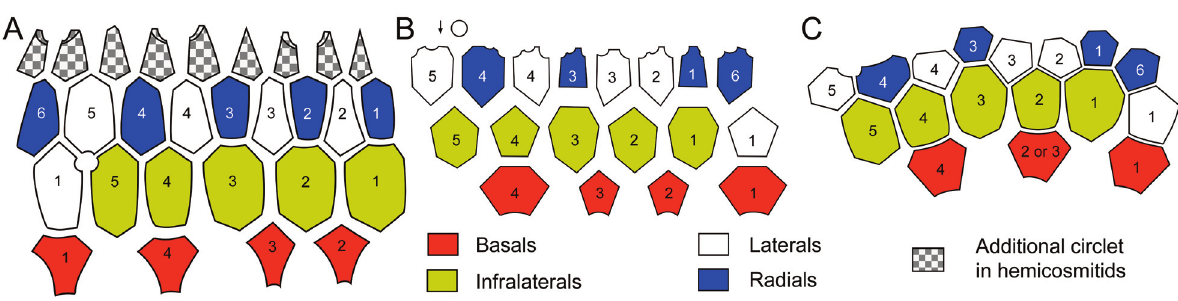
Fig. 10. Reinterpretation of the plate homologies in the lower three circlets of ( A ) Hemicosmites , ( B ) Caryocrinites and ( C ) Thomacystis . The basal circlet is unchanged. The plates in the second circlet are interpreted as plates IL1–IL5 and L1. The nine plates in the third circlet are interpreted as the remaining four laterals L2–L5 and five radials R1–R3 and R5, R6 in Hemicosmites ( A ). Caryocrinitids ( B ) and Thomacystis ( C ) lack R2, the radial plate directly above IL2 in Hemicosmites . Redrawn and relabelled from: A , Bockelie (1979, fig. 4A, p. 371); B , Frest (1975, fig. 2, p. 86); C , Paul (1984, fig. 87A, p. 144). Arrow and circle in B denote positions of gonopore and periproct,